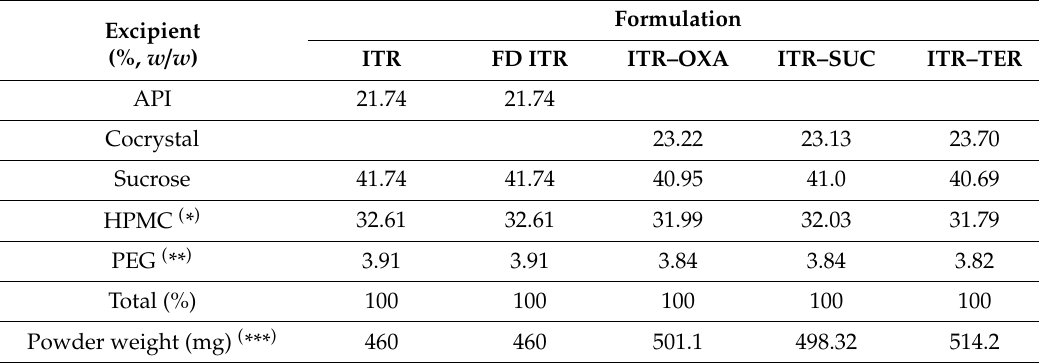
Table 1. Composition of the powders used in the dissolution